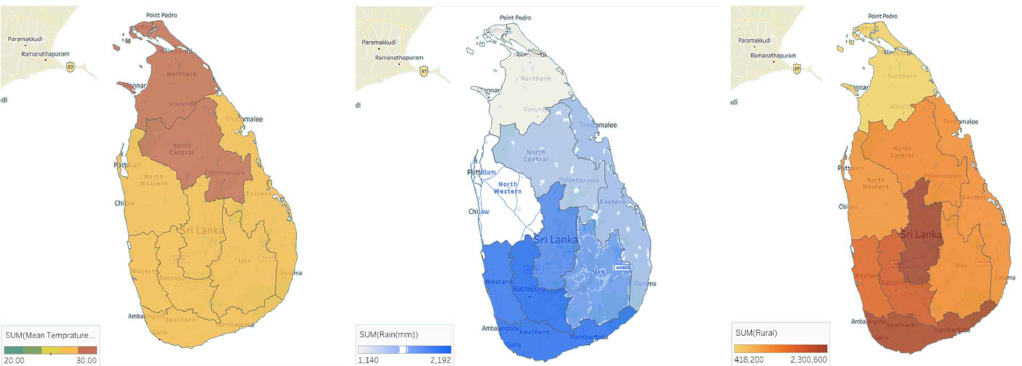
Figure 4. Projection of population increase in Sri Lanka (source: United Nations—World Population Prospects).